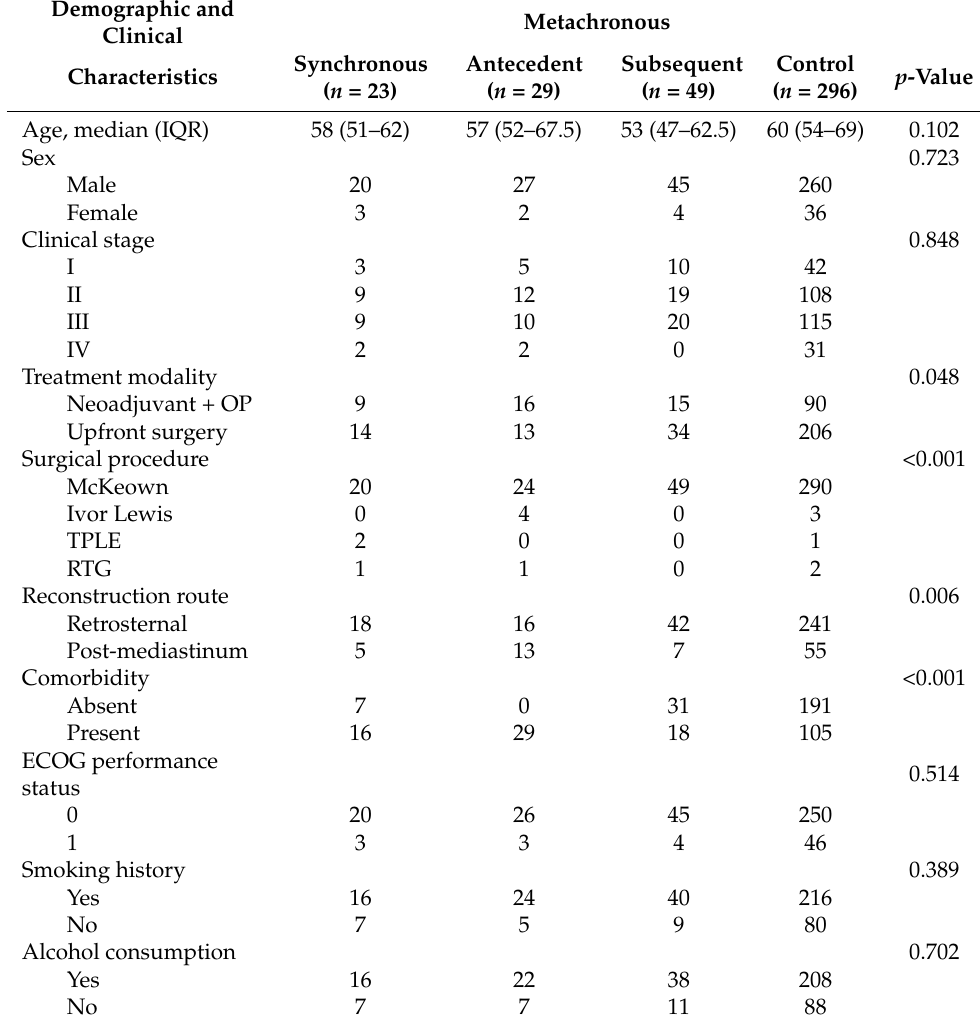
Table 1. Characteristics of multiple primary cancers and control